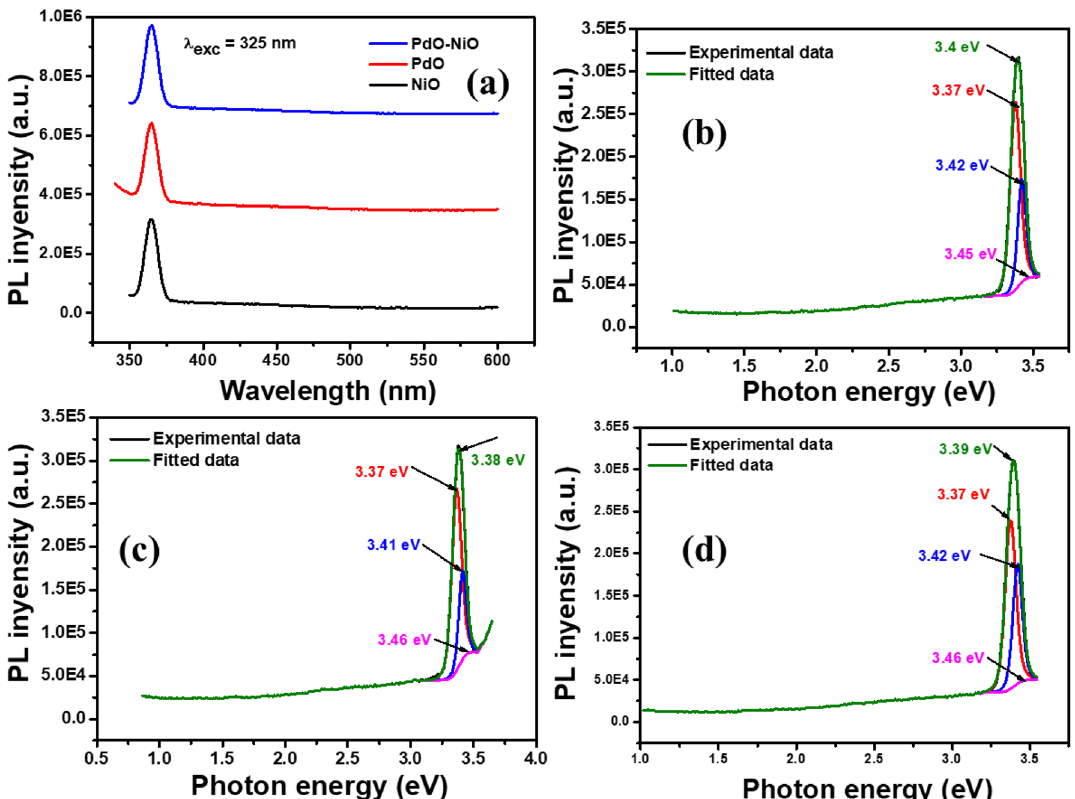
Figure 6. ( a ) PL spectra and ( b – d ) deconvoluted spectra of NiO, PdO and PdO–NiO nanocomposite